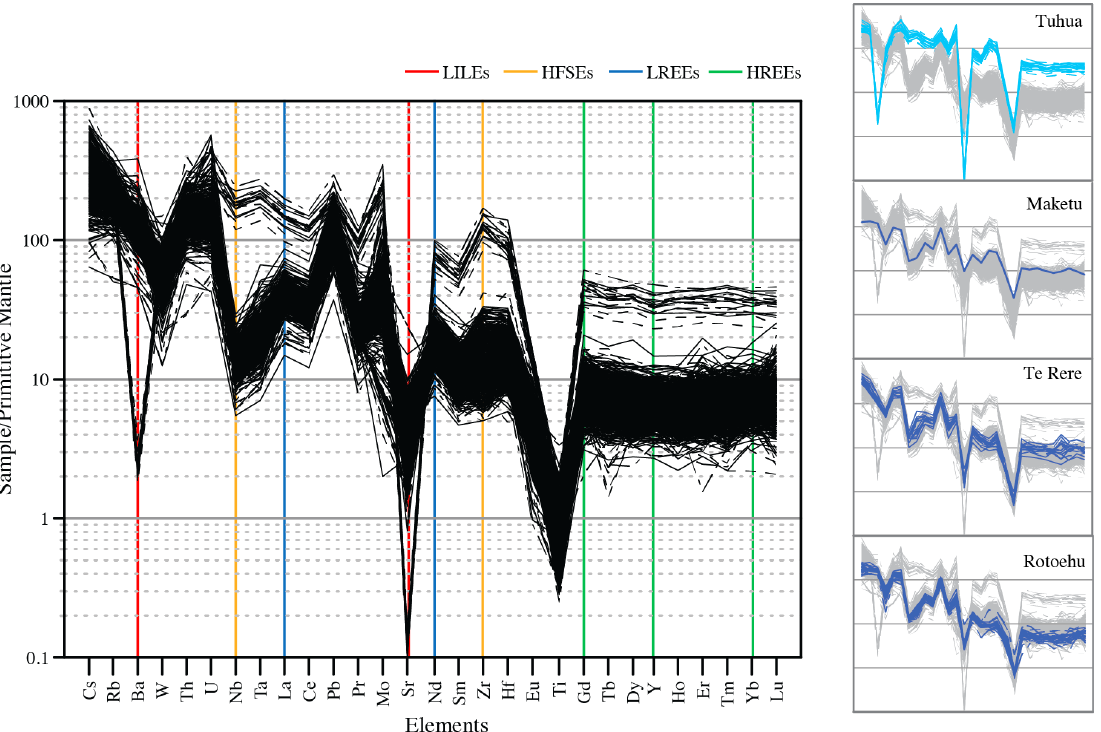
Figure 8. Primitive mantle normalised (McDonough and Sun, 1995) trace-element spider plot for glass analyses for all reference samples. Highlighted are key elements discussed in the text coloured by their characteristics including HFSE, LILE, LREE, and HREE. The full plot is presented to show the density of data with the dominant trend line plus the obvious deviations from this. The samples which correspond to these deviations are shown in the smaller plots at right, including analyses on glass from Tuhua (MI), Maket¯u, Te Rere, and Rotoehu (OVC) tephras. The Rotoehu Ash signature is also similar to that for the Rotoiti Ignimbrite (which are coeval deposits; Nairn and Kohn, 1973), the Earthquake Flat tephra (Kapenga VC; Nairn and Kohn, 1973), and the Ng¯amotu tephra (OVC; Jurado-Chichay and Walker,